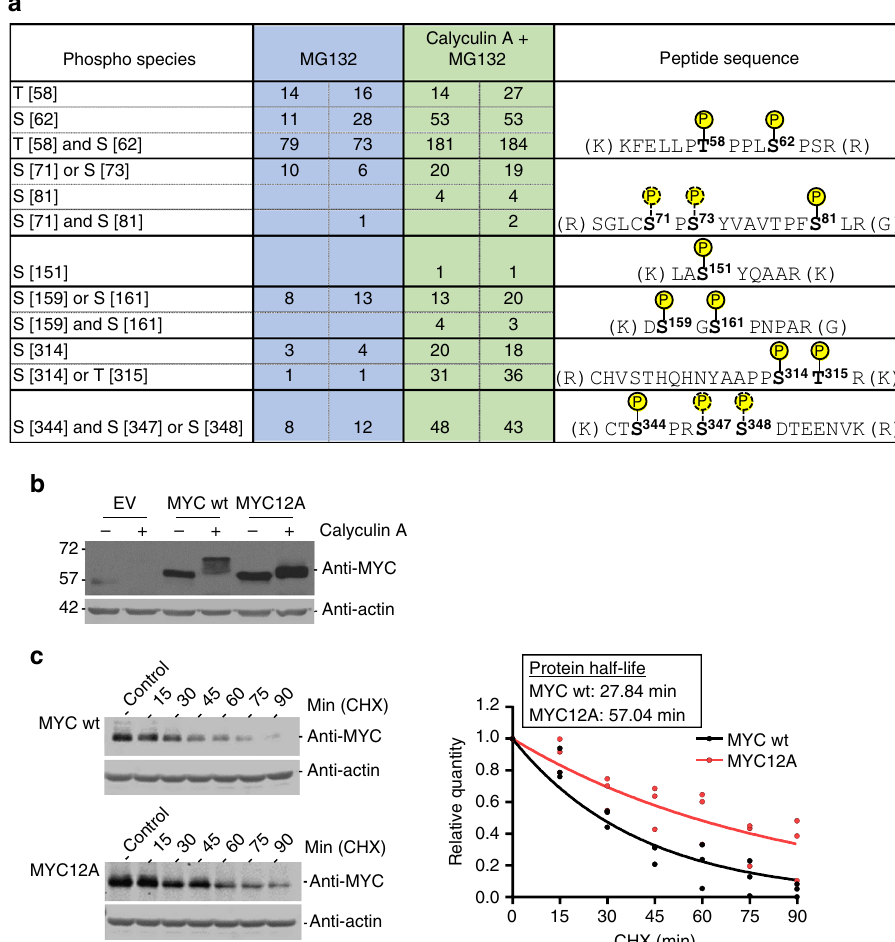
Fig. 5 PP1 dephosphorylates multiple serine and threonine residues on MYC. a Growing MCF10A cells were treated with MG132 (10 µ M) for 4 h ± Calyculin A (50 nM) for 30 min, lysed, and MYC immunoprecipitated and then subjected to trypsin digestion, phospho-enrichment and analysis by MS. Shown are the peptide counts from two technical replicates as well as the peptide with the indicated phospho-sites. b MCF10A cells treated with 4-OHT (48 h) to induce expression of empty vector (EV) wildtype MYC (MYC wt) or a MYC mutant in which the 12 Ser and Thr residues identi fi ed in a were mutated to Ala (MYC12A), were treated with Calyculin A (50 nM) for 30 min and lysed. Protein lysate (20 µ g) was loaded on 10% SDS-PAGE, transferred onto nitrocellulose membrane and immunoblotted with MYC mouse or actin rabbit antibody. Shown are representative images of n = 3. c MCF10A cells expressing MYC wt or MYC12A after 4-OHT (24 h) induction were treated with cycloheximide (CHX) (10 µ g/mL), harvested at 15-min intervals, lysed, resolved by SDS-PAGE and immunoblots probed with MYC or actin antibody (left). The MYC band intensities were quanti fi ed and signal normalized to actin. Shown are the normalized MYC signals for three replicates with protein half-life determinations